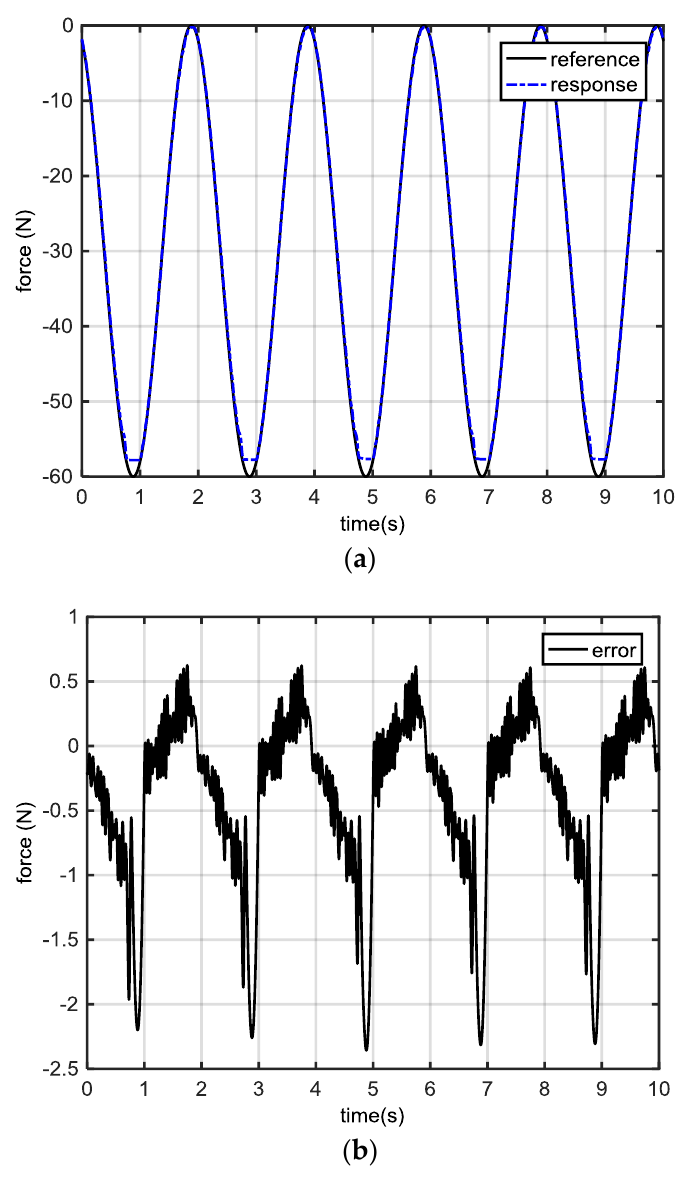
Figure 6. ( a ) Response profiles of mover1 and ( b ) the error response waveform with